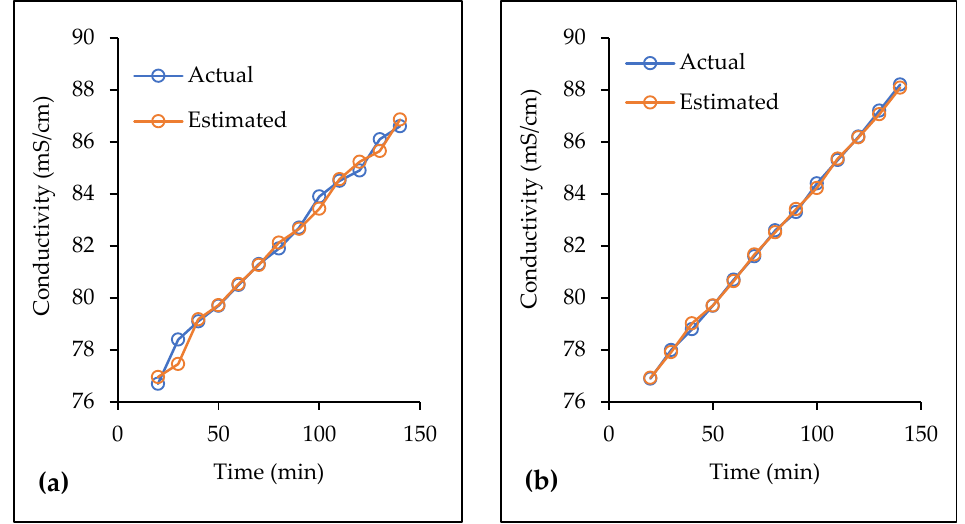
Figure 5. Measured and estimated conductivity values for NaCl draw solution for the case of ( a ) 0.25-C-AL (2nd run) and ( b ) 1.0-CC-SL (1st run).